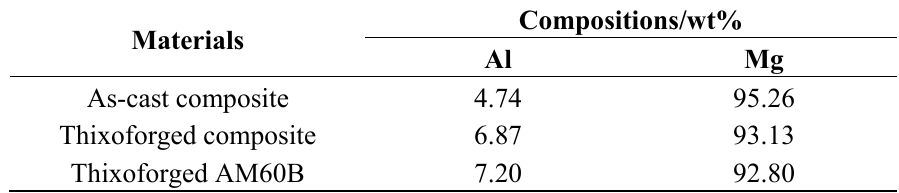
Figure 1. OM micrographs and SEM images of: ( a , b ) as-cast composite; ( c , d ) thixoforged composite; and ( e , f ) thixoforged AM60B. Table 2. Compositions of primary α-Mg dendrites or the grains of these